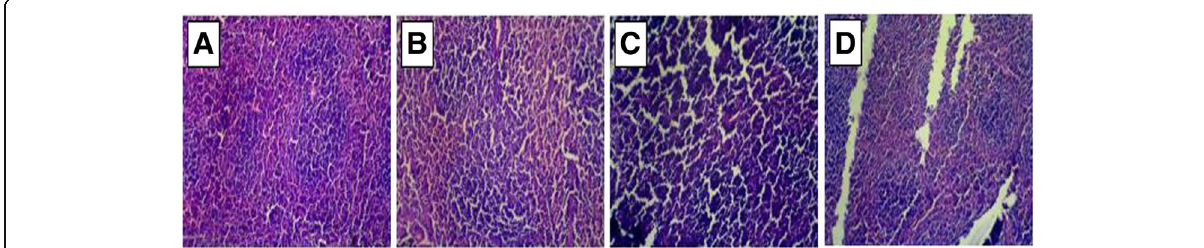
Fig. 12 Histopathological analysis of spleen tissue in various concentration. a : Control group, b : Low dose (300 mg/kg), c : Mild dose (600 mg/kg), d : High dose (1200